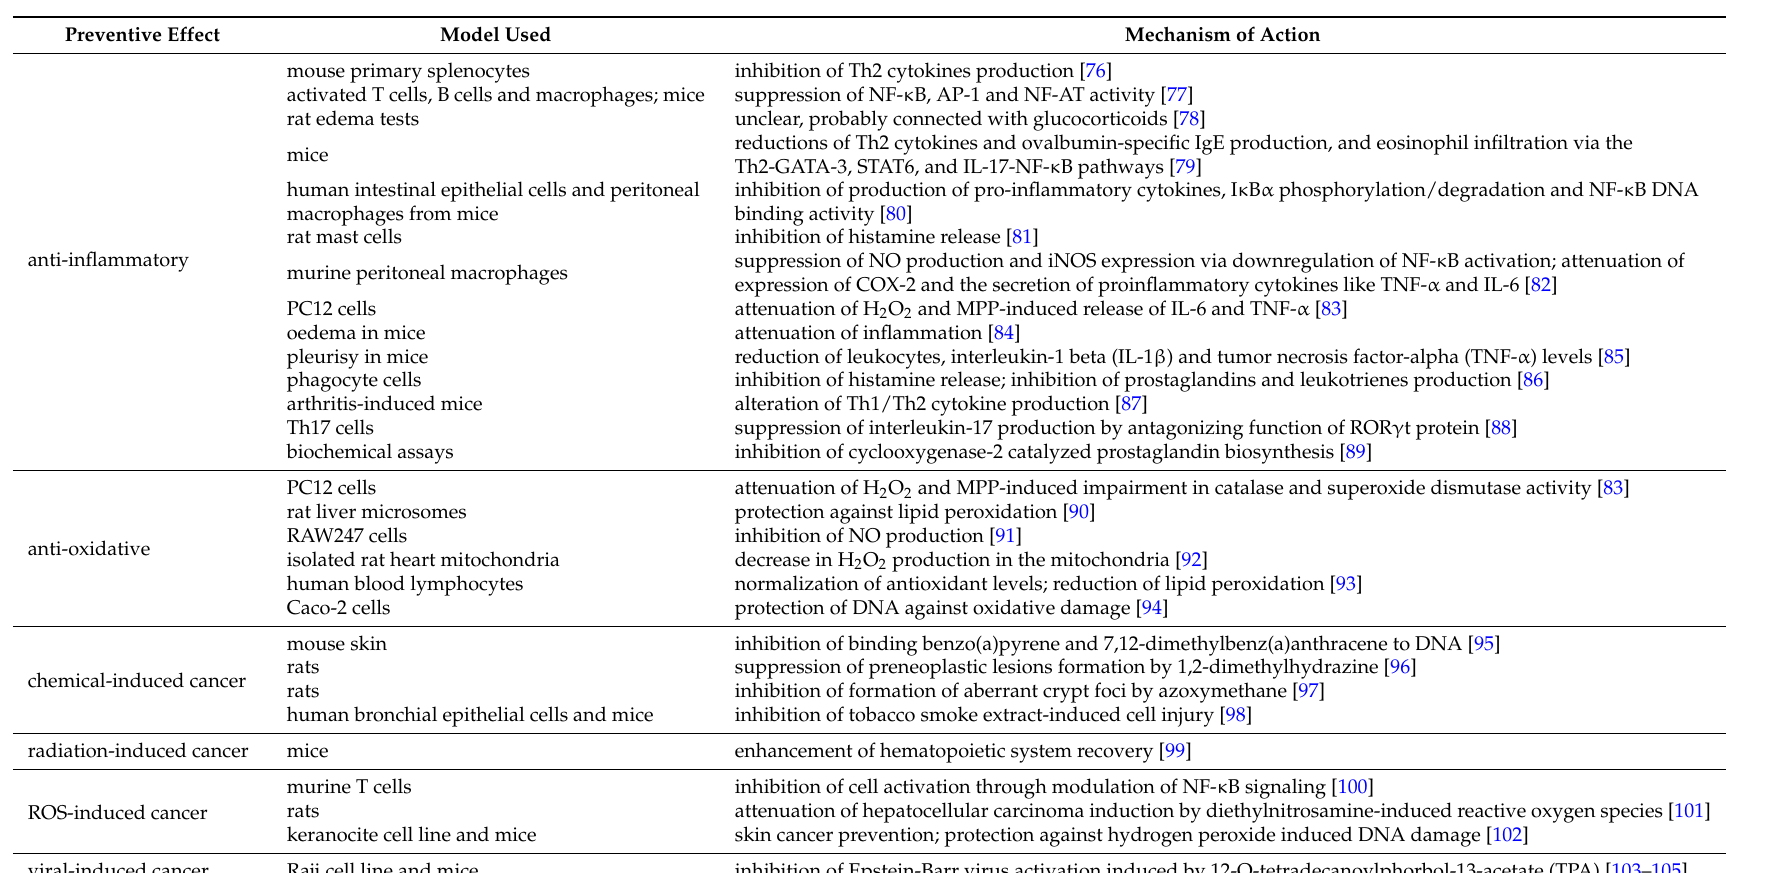
Table 2. Ursolic acid in cancer